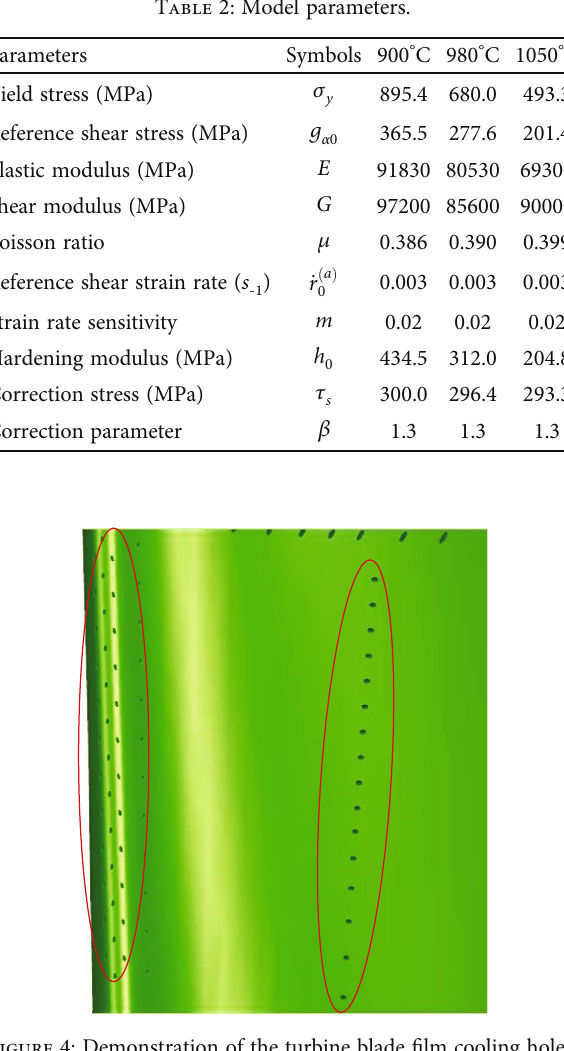
Figure 4: Demonstration of the turbine blade fi lm cooling